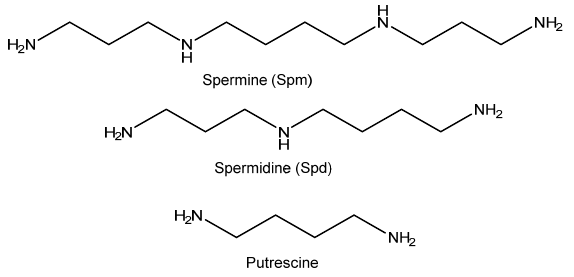
Figure 1. Structure of biological polyamines.